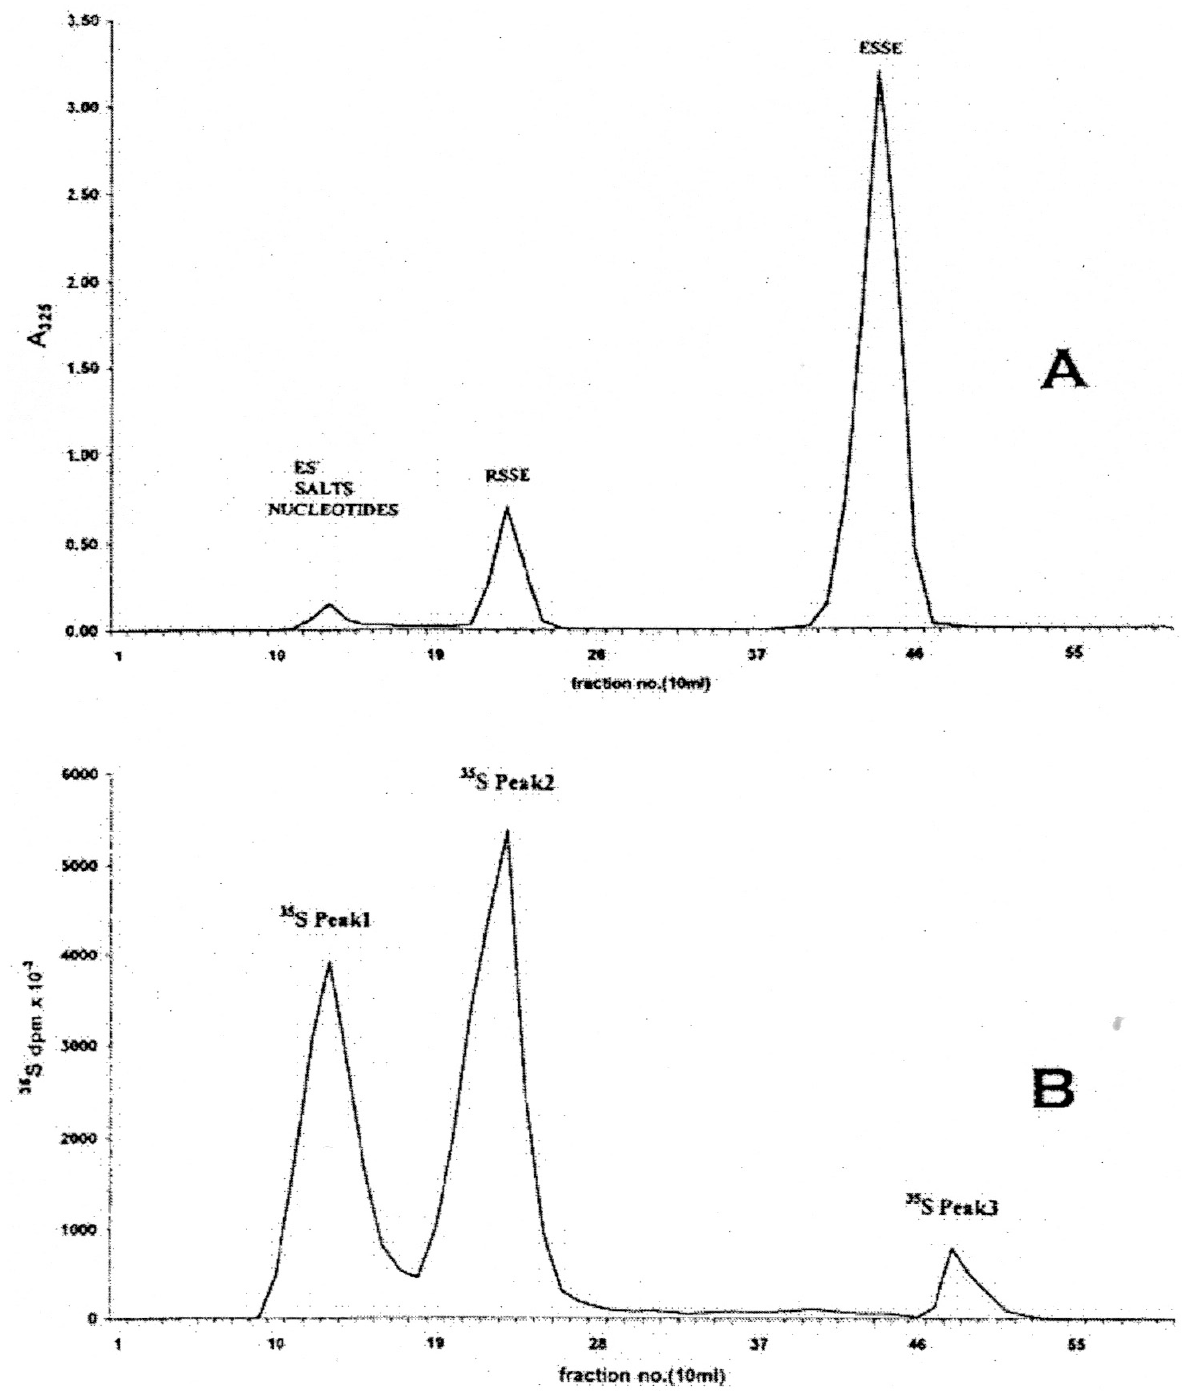
Figure 1. Initial chromatographic separation of LNCap cell acid soluble thiol reactants with a three-fold excess of ESSE on a 30 × 2.5 cm column of ODS-AQ gel using 10–15 mL of sample saturated with NaCl. Elution: flow rate 1 mL/min, 200 mL water followed by a 400 mL linear gradient to 40% methanol; 10 mL fractions. (A) 325 nm absorbency trace from a bulk preparation; (B) 35 S trace from cells labeled in monolayer ( circa 80% confluent) for 4